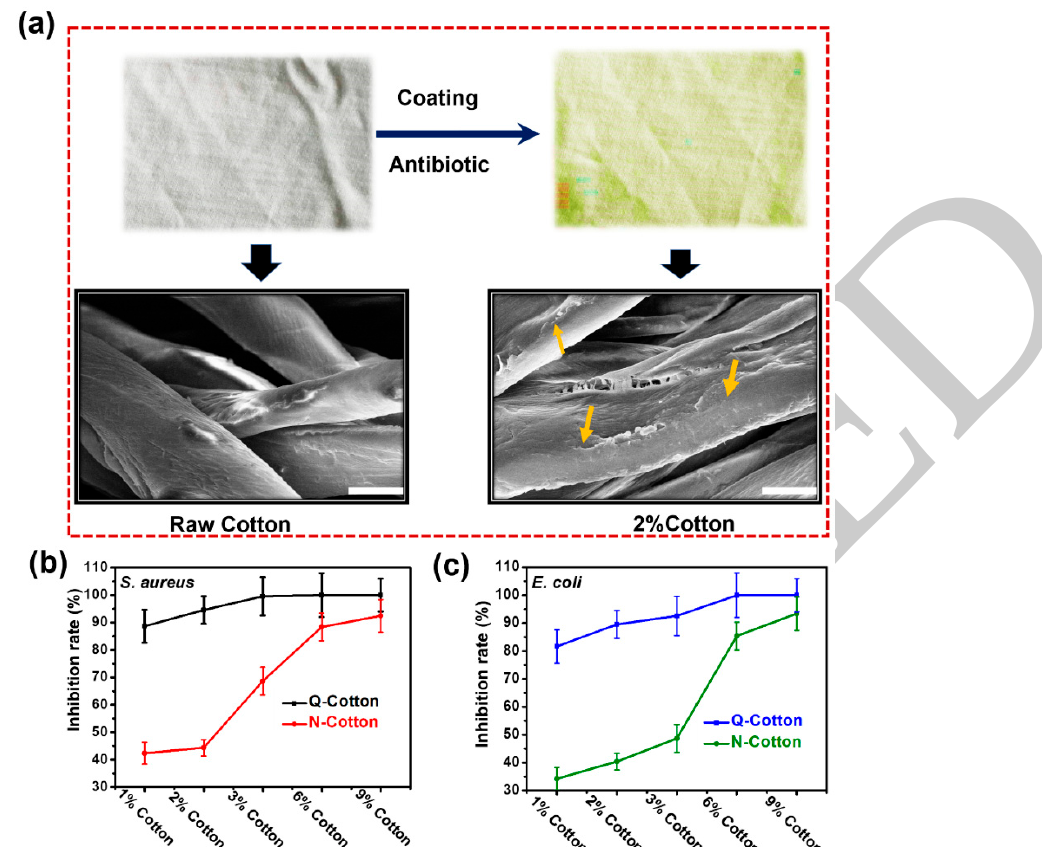
Figure 1. ( a ) The optical and SEM images of raw cotton fabrics and cotton fabrics finished with CDDA. The bar is 10 µm. ( b ) The antibacterial properties of cotton fabrics against S. aureus ( c ) and E. coli after washing 50 times with the addition of anionic detergent. Q-cotton fabrics were washed with pure water, N-cotton fabrics were washed with anionic detergent in water.